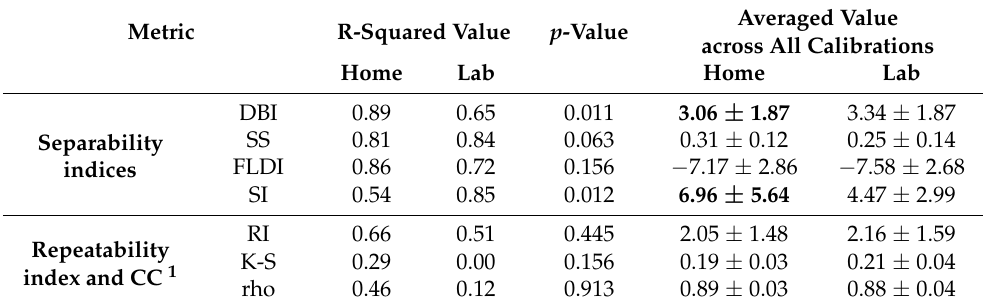
Table 3. Average classification error across calibrations.